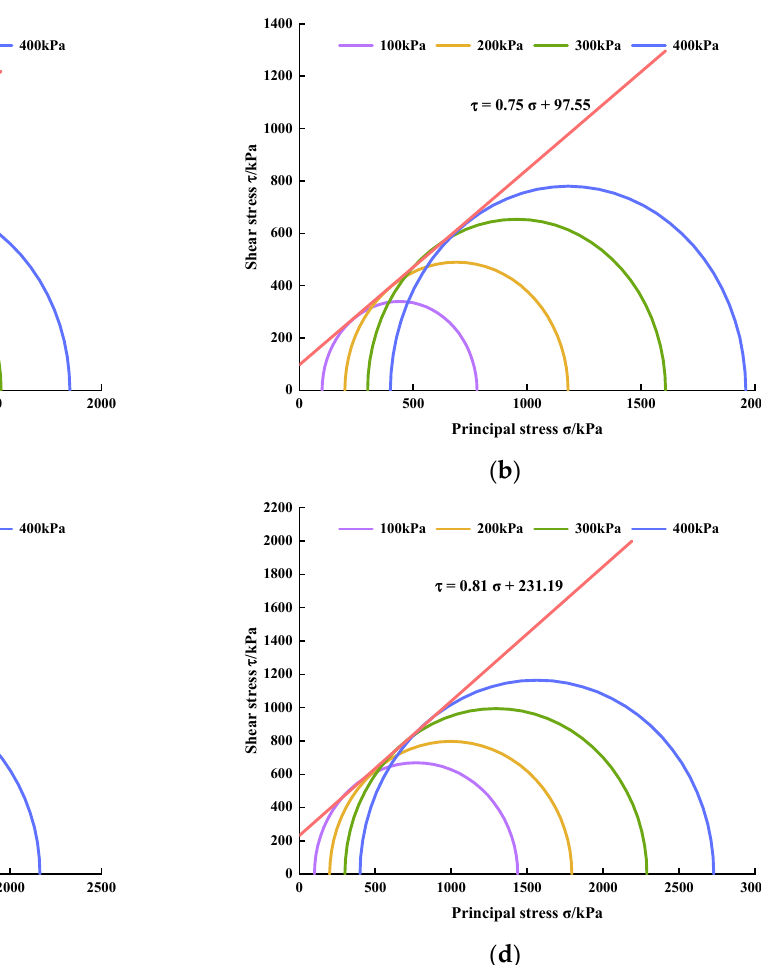
Figure 10. Limit Mohr stress circles and shear strength envelopes of PURD at 28 days of curing time. ( a ) PURD-3; ( b ) PURD-4; ( c ) PURD-5; ( d ) PURD-6.